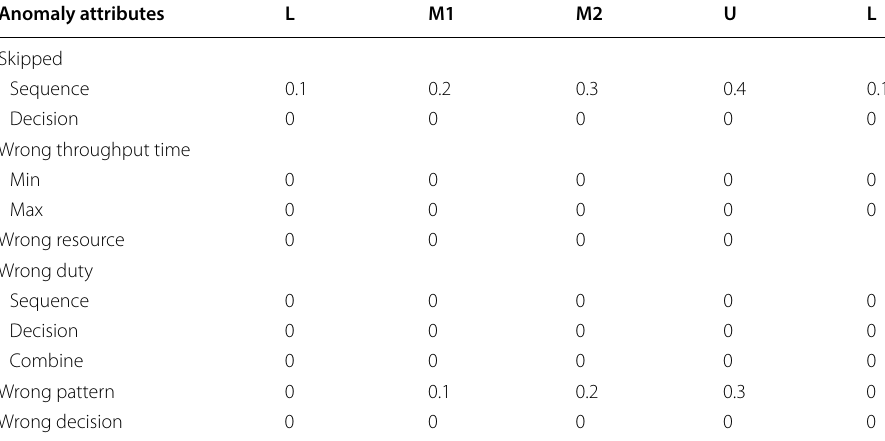
Table 7 Evaluation of anomaly attribute occurrence rate for a case (S) Anomaly